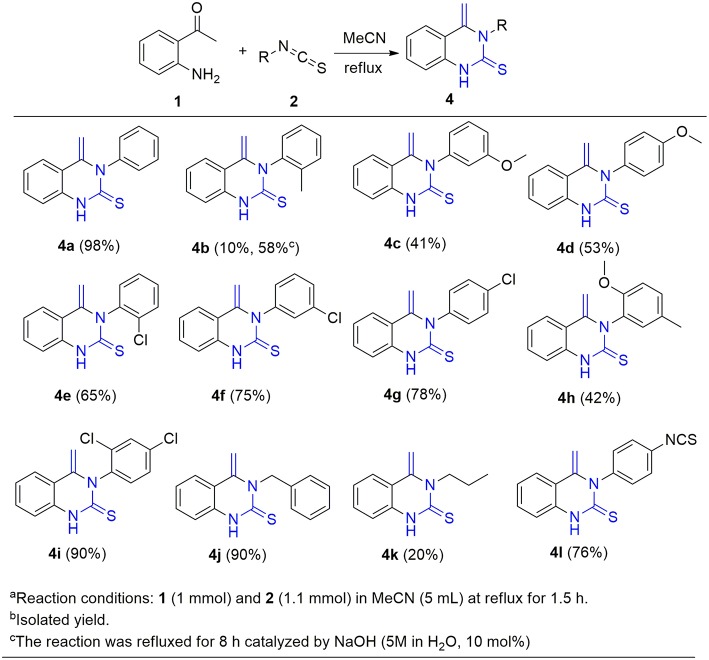
Substrate scope of isothiocyanatesa,b.